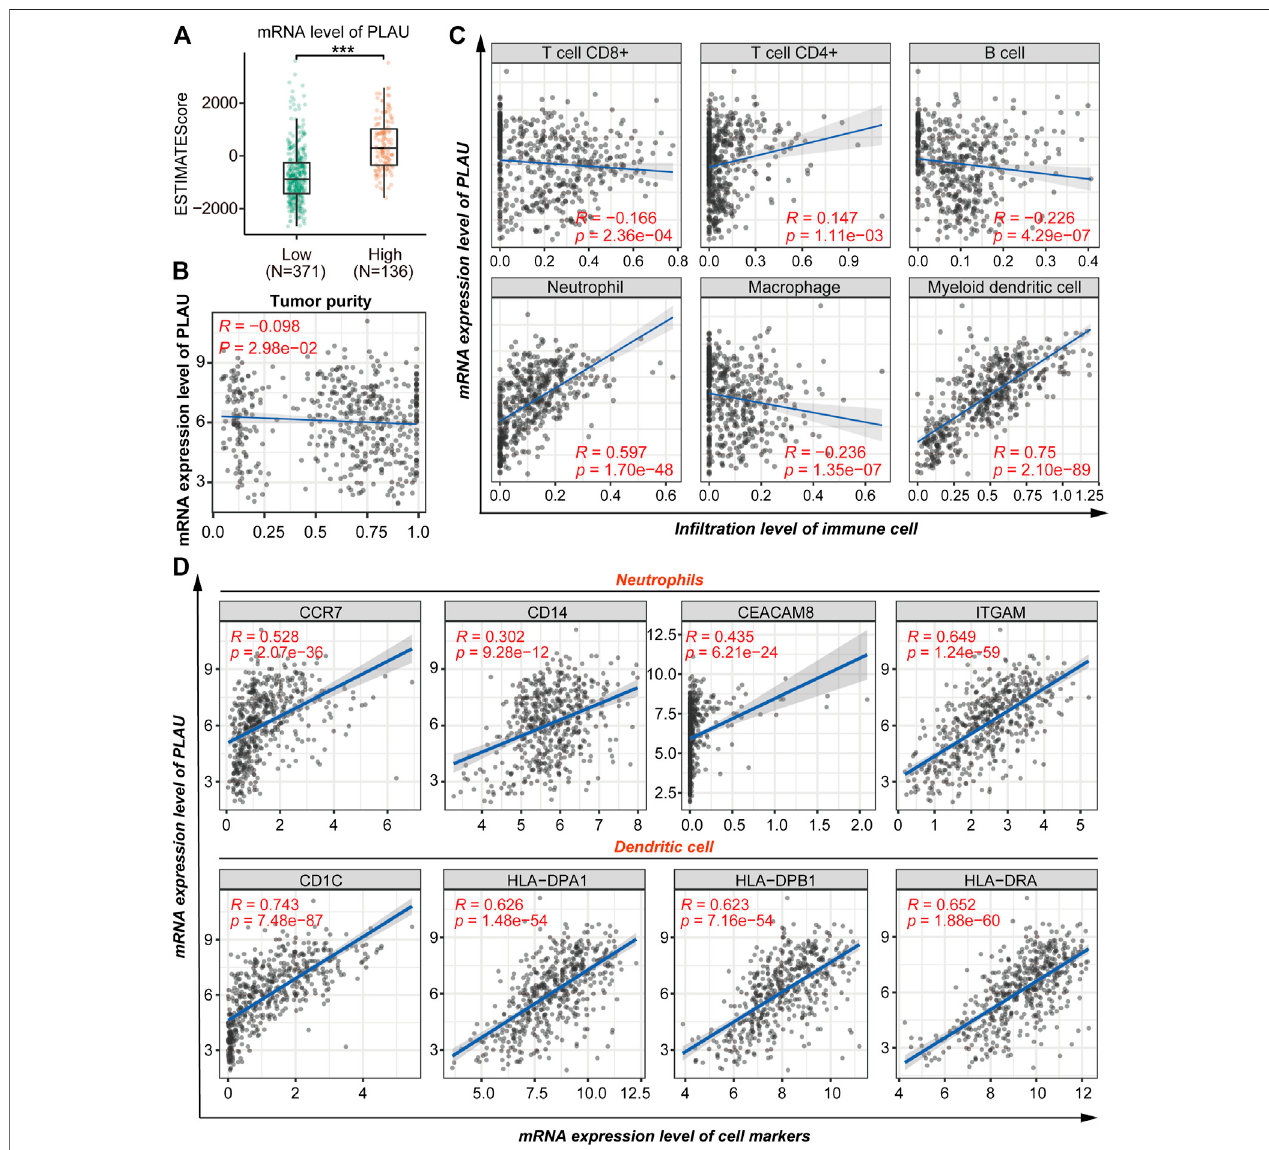
FIGURE 6 | Correlation analysis of PLAU and immune cell in fi ltration. (A) Comparison of the immune scores (presented as the ESTIMATE Score) between THCA patients with different mRNA levels ofPLAU, Student ’ st-test, ** p < 0.01, *** p < 0.001. (B) Correlation between the mRNA level ofPLAU and tumor purity wasevaluated usingPearson ’ scorrelationtest. (C) PearsoncorrelationwasappliedtoanalyzethecorrelationbetweenthemRNAlevelofPLAUandthein fi ltrationlevelofimmunecells. (D) Pearson correlation was applied to analyze the correlation between the mRNA level of PLAU and the cell markers of the neutrophils and dendritic cells.